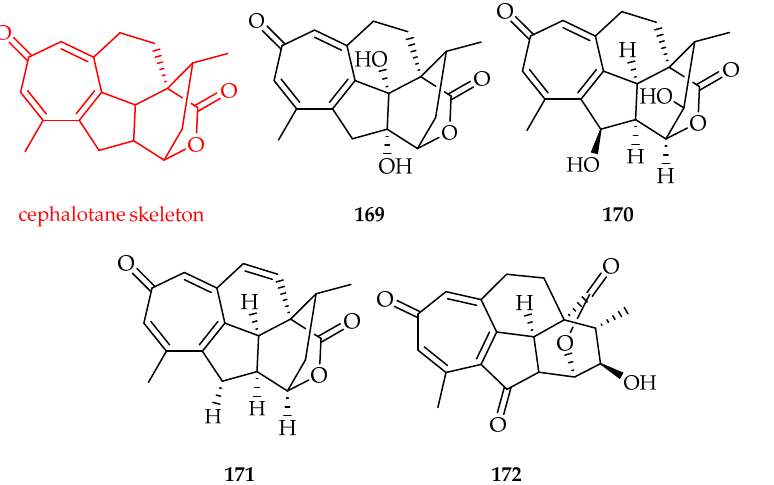
Figure 72. Structures of cephalotane skeleton, fortalpinoids E, F, and H 169–171 [111], and 20-Oxo- hainanolidol 172 [112].